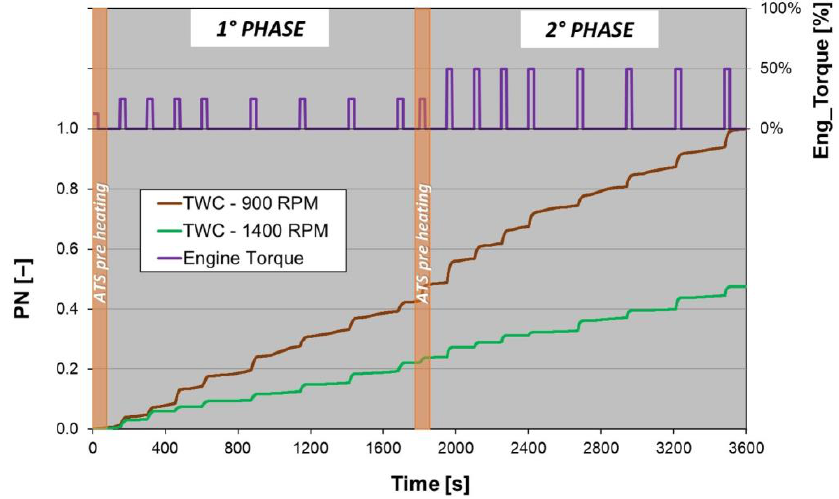
Figure 8. The 9 00 and 1400 rpm test dimensionless mean PN emissions for the “TWC” configuration related to the engine torque